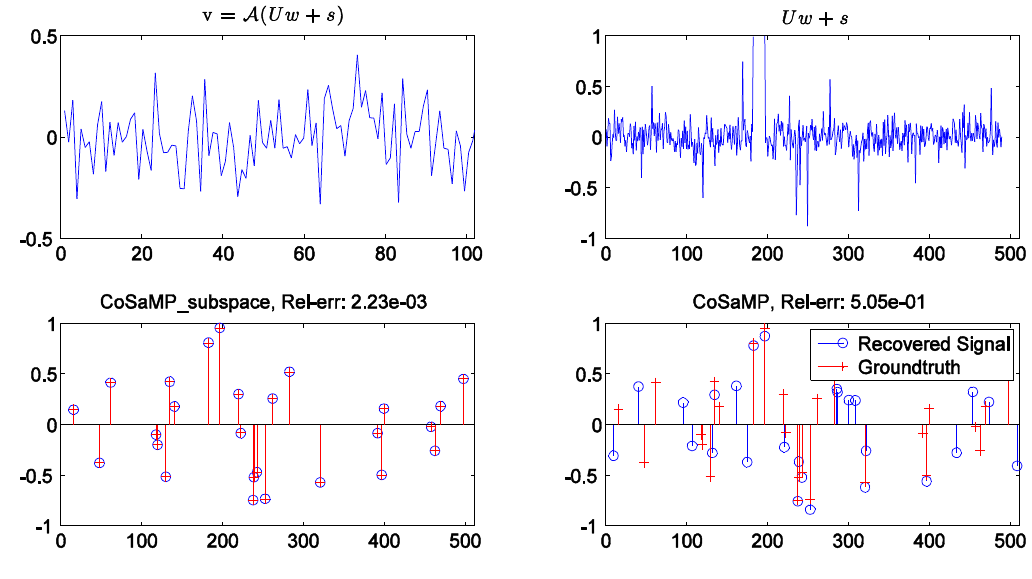
Figure 5. Noisy sparse signal recovery comparison between CoSaMP_subspace and ordinary CS (CoSaMP). Top-left is the compressive measured signal v ; top-right is the uncompressed signal—―dense structured signal + sparse signal‖; bottom-left is the recovered sparse signal by our algorithm; bottom-right is the recovered sparse signal by ordinary